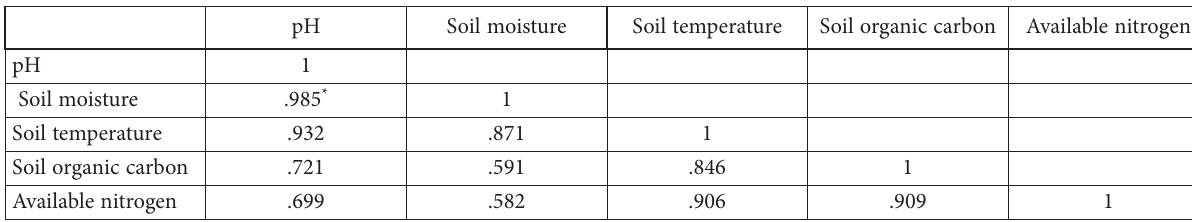
Table 4. Correlation matrix among the soil parameters at